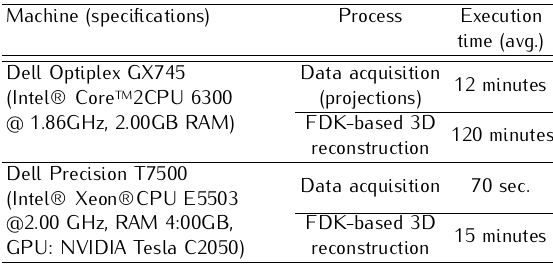
Table 3. Comparison of Execution